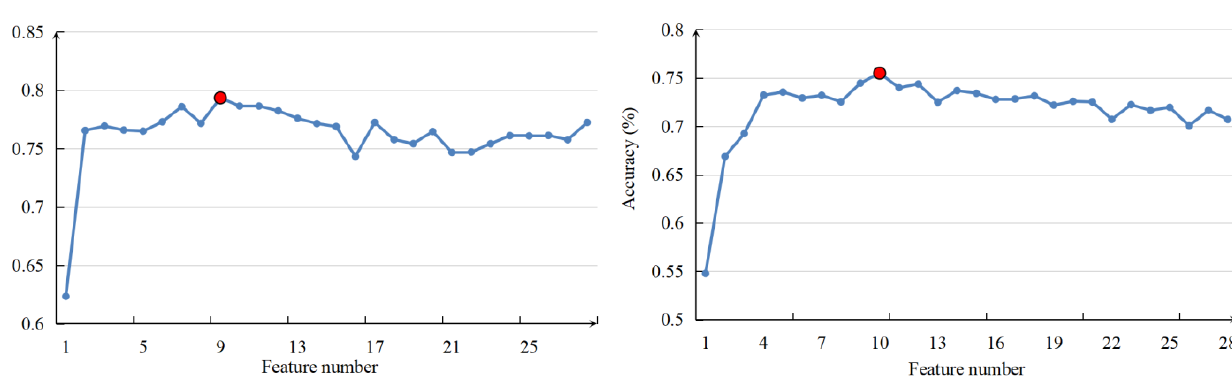
Figure 7. Variations of selected features in different groups of leaves for scenario-A ( left) and scenario-B ( right ) for the training dataset.